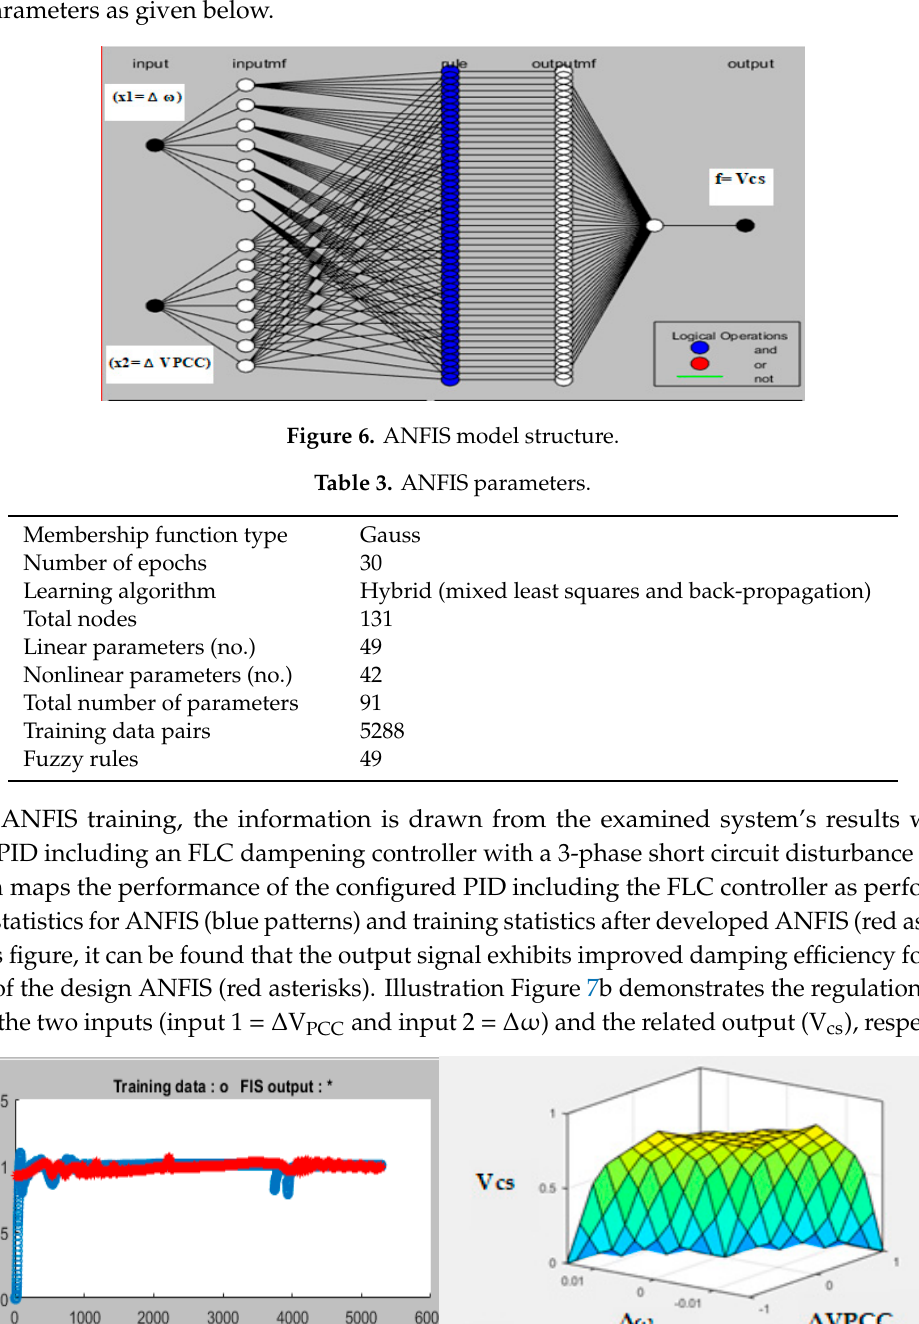
Figure 7. ANFIS training data outcome and control surface. ( a ) Training data outcome. ( b ) Suggested ANFIS control surface.